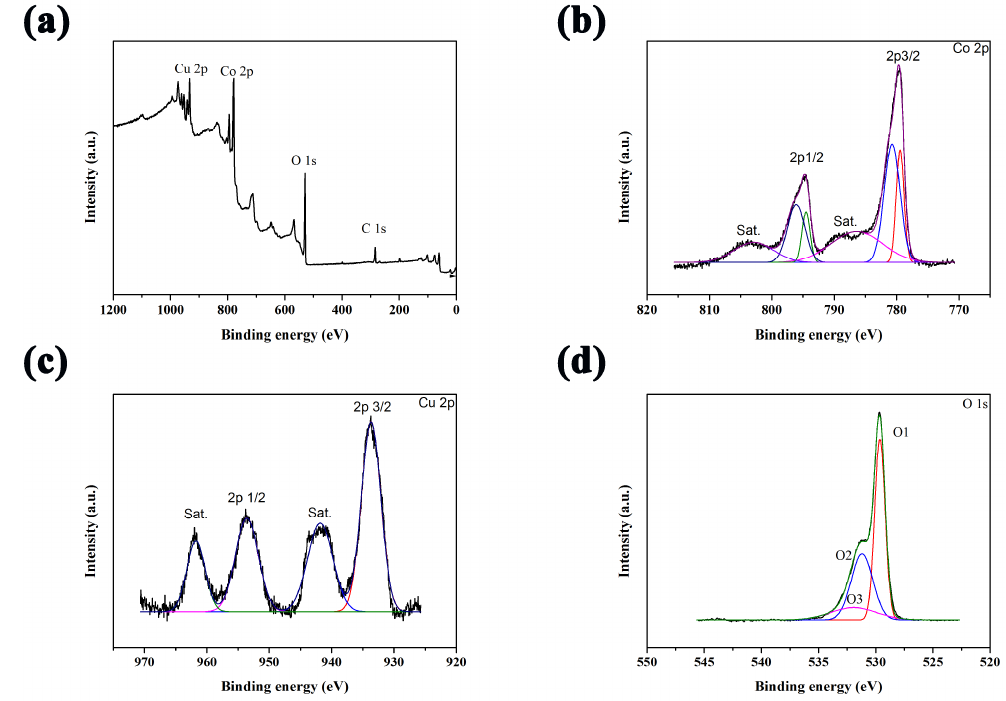
Figure 3. ( a ) XPS survey spectrum, XPS spectra of ( b ) Co 2p, ( c ) Cu 2p, and ( d ) O 1s for CuCo 2 O 4 nanosheets.